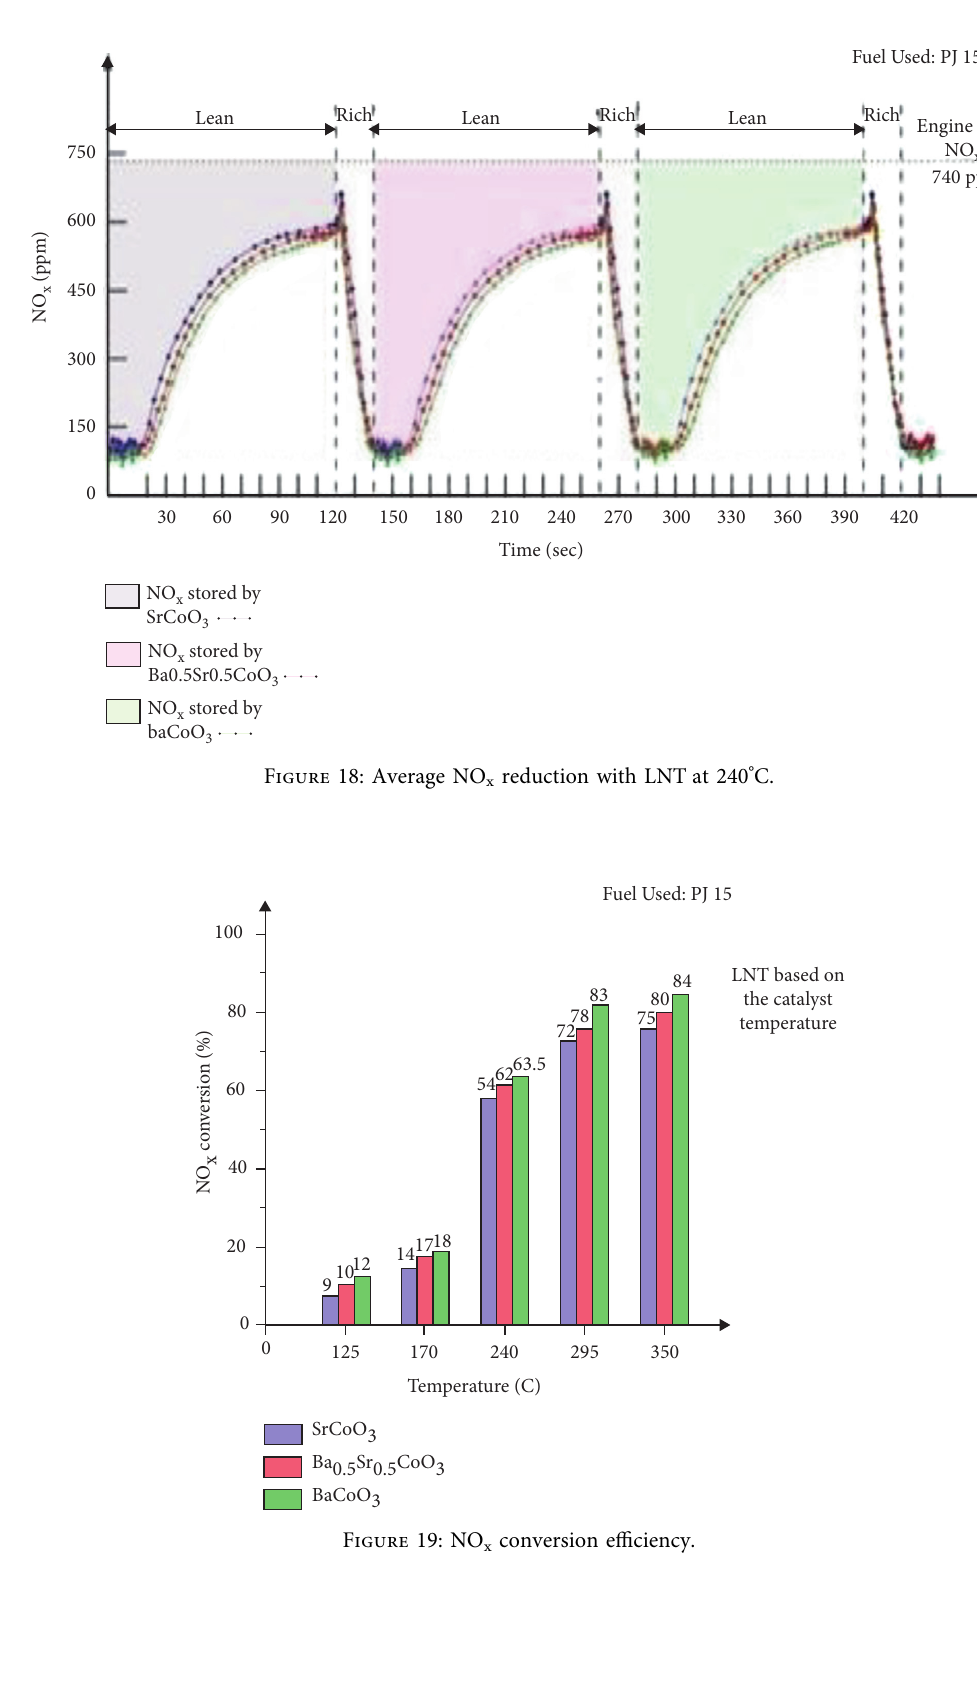
Figure 19: NO x conversion